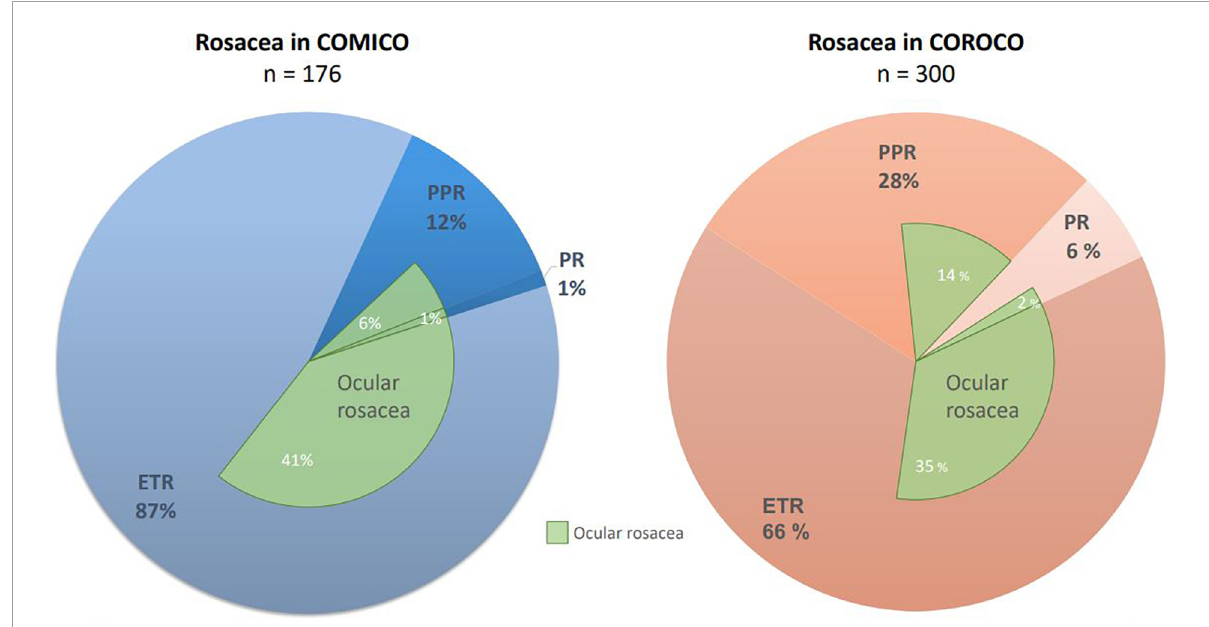
FIGURE3 Distribution of rosacea subtypes in each cohort. ETR, erythematotelangiectatic rosacea; COROCO, Copenhagen Rosacea Cohort; COMICO, Copenhagen Migraine Cohort; PPR, papulopustular rosacea; OR, ocular rosacea; PR, phymatous rosacea.